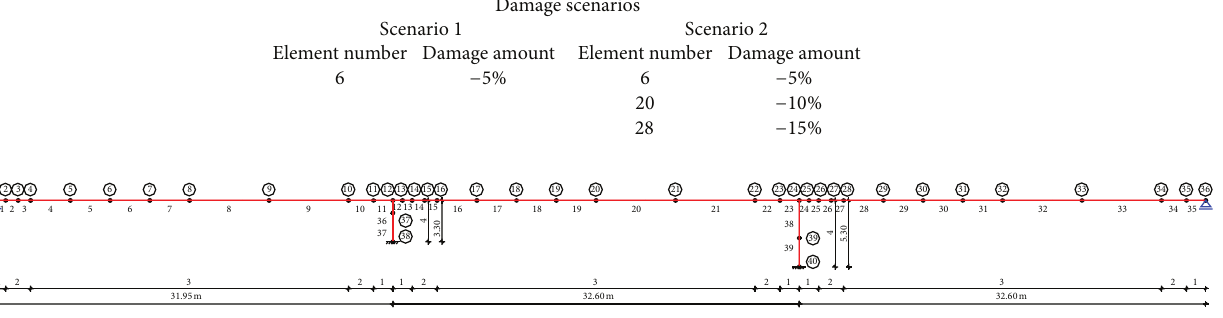
Figure 1: Concrete girder bridge model problem.